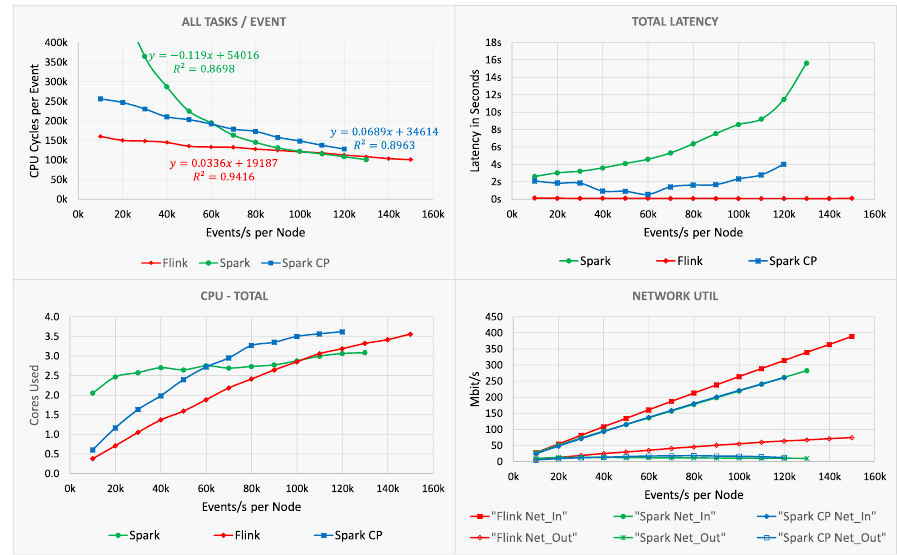
Figure 7. Total CPU and network consumption when scaling the